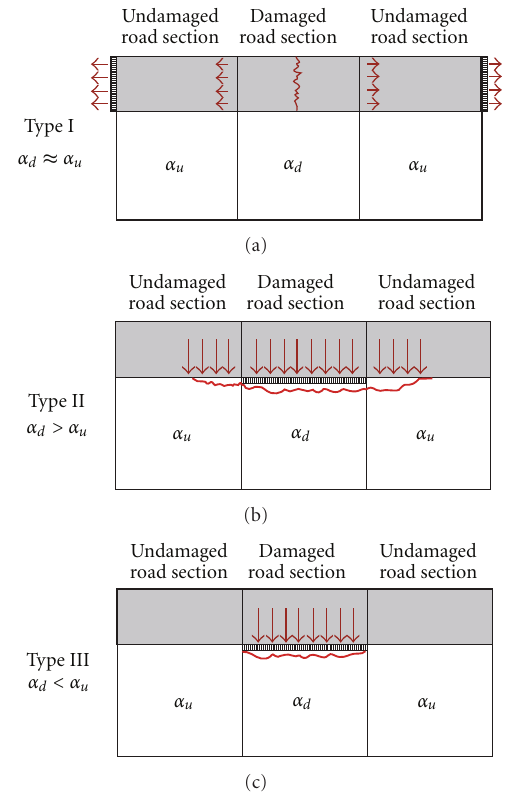
likely cause of degradation is fatigue or thermal shrinkage due to horizontal tensile stresses developing in layer S1 of the road pavement (Figure 8(a)). Indeed, in this instance, the energy curves in layer S2 almost coincide. This means that the subgrade soils of the two road sections (damaged and undamaged) have the same density and are not undergoing compaction (Figure